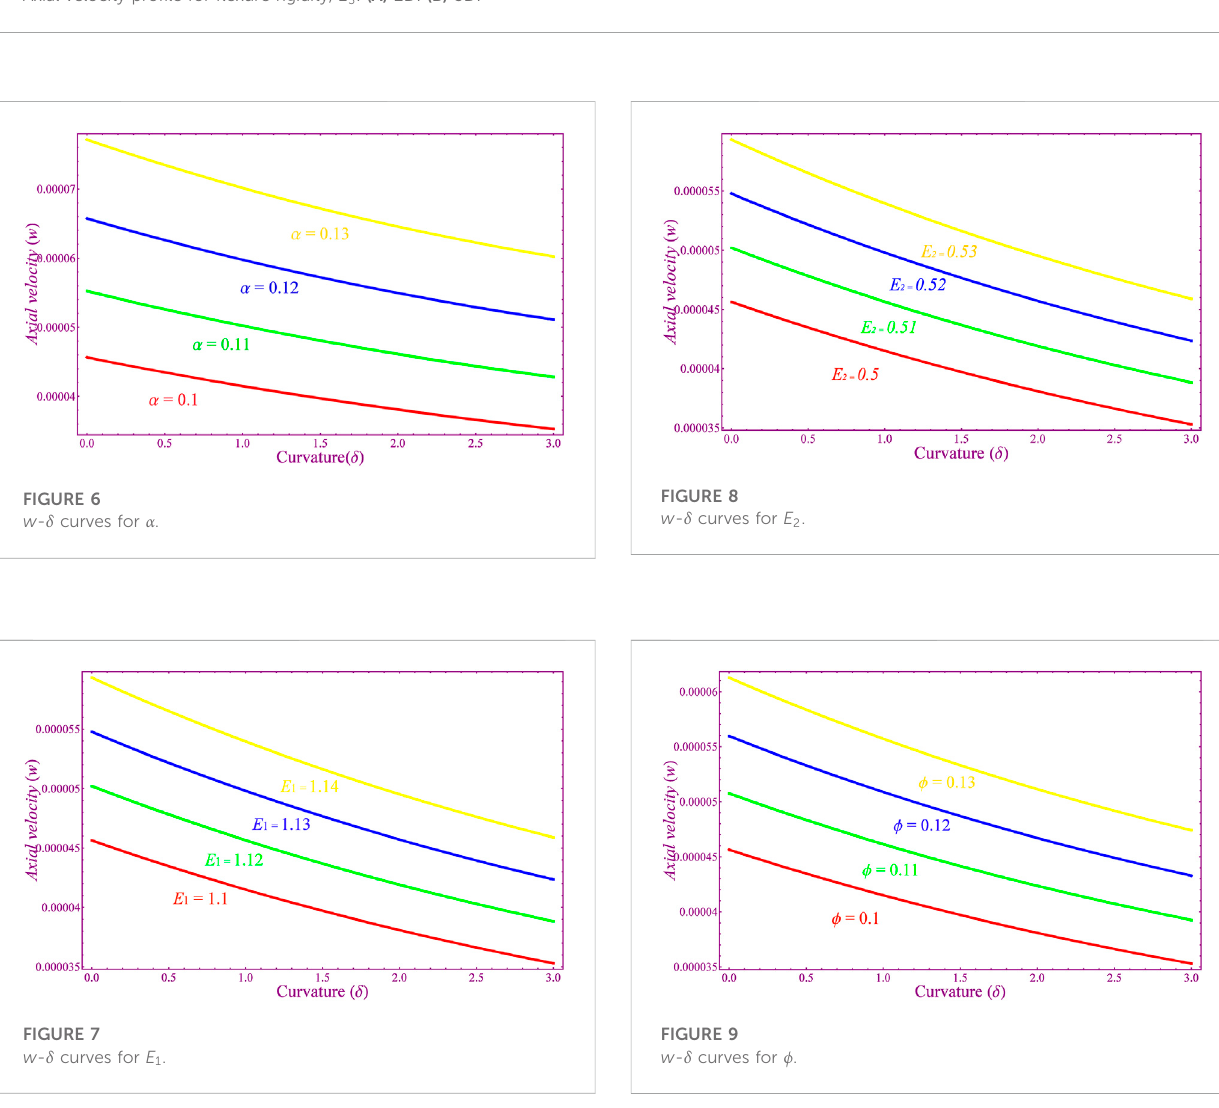
fl ow. Figures 10 and 11 have been included to estimate the quantitative analysis of contourvariations for various emerging parameters like α , andE_1, correspondingly.